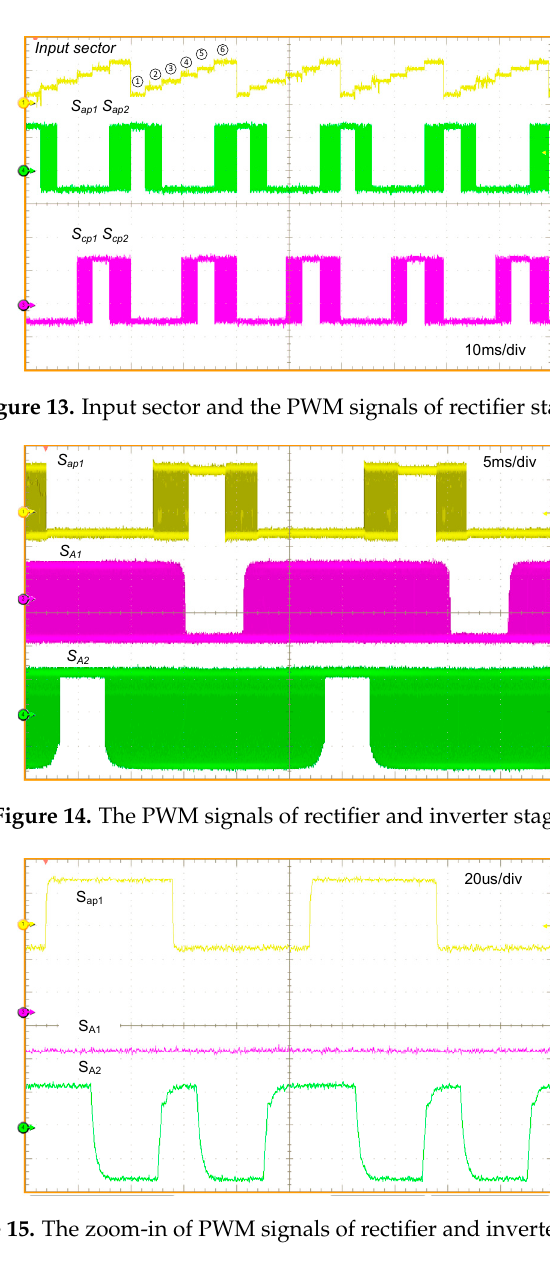
Figure 16. Experimental results of input side.